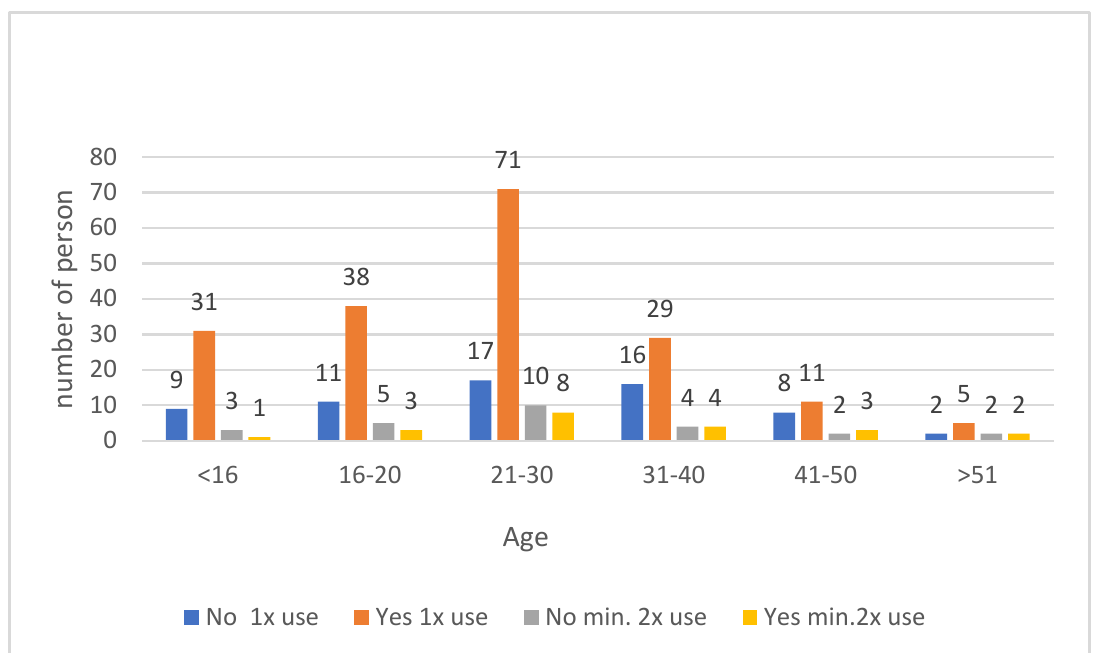
Figure 2. Use of antimalarial drugs without consultation with medical personnel across age groups.